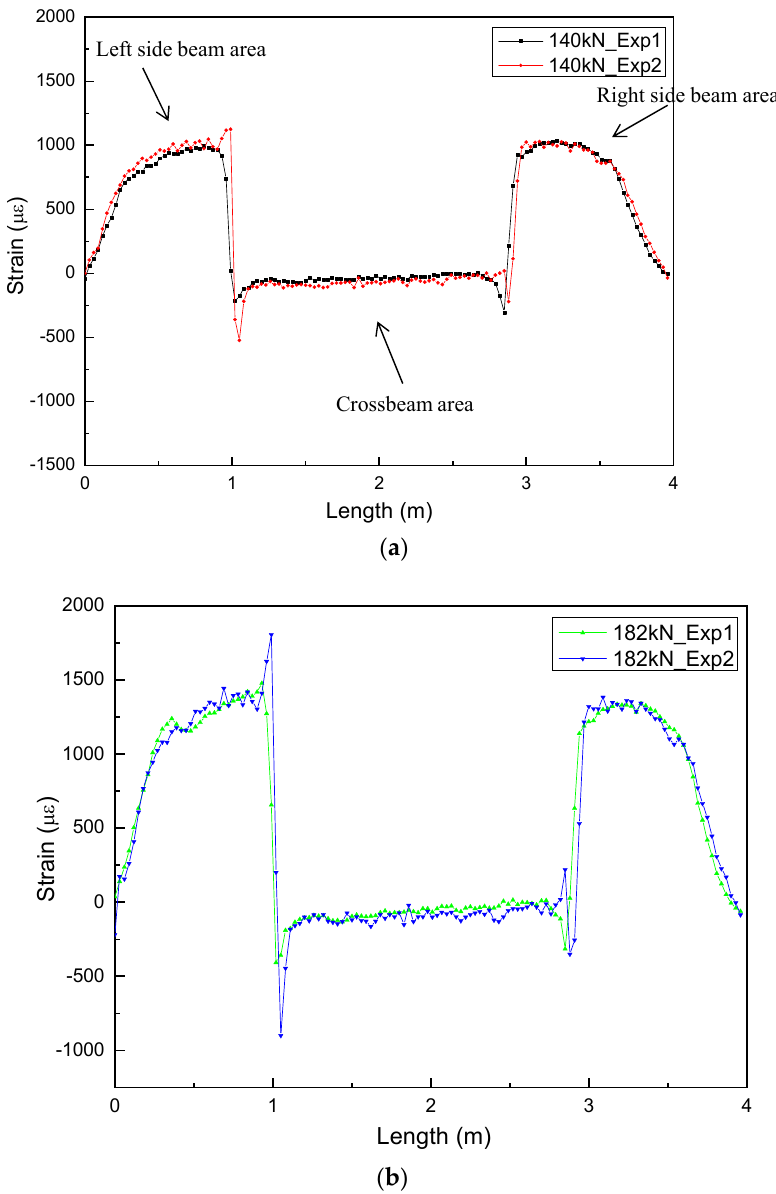
Figure 10. Strain distribution measured using an embedded optical fiber during a vertical train load test of a composite bogie frame with a: ( a ) 140 kN vertical load; and ( b ) 182 kN vertical load.